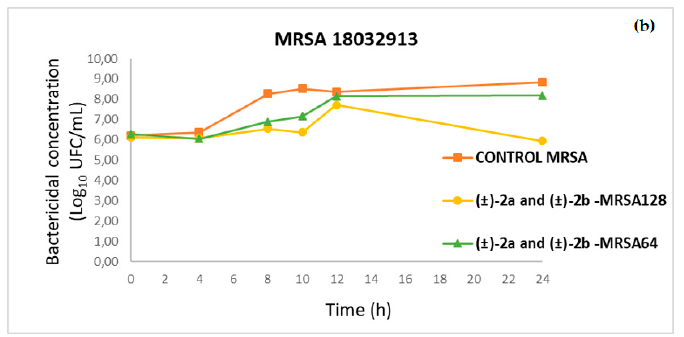
Figure 6. ( a ) Time-kill curve of S. aureus ATCC 25923; ( b ) Time-kill curve of MRSA 18032913. Stereoisomers 2 ((±)-2a and (±)-2b) presented bactericidal effects against S. aureus at 64 and 32 mg/L after 4 h. These effects are decreasing whenever the time is increasing. These reductions did not persist noteworthy at 24 h.